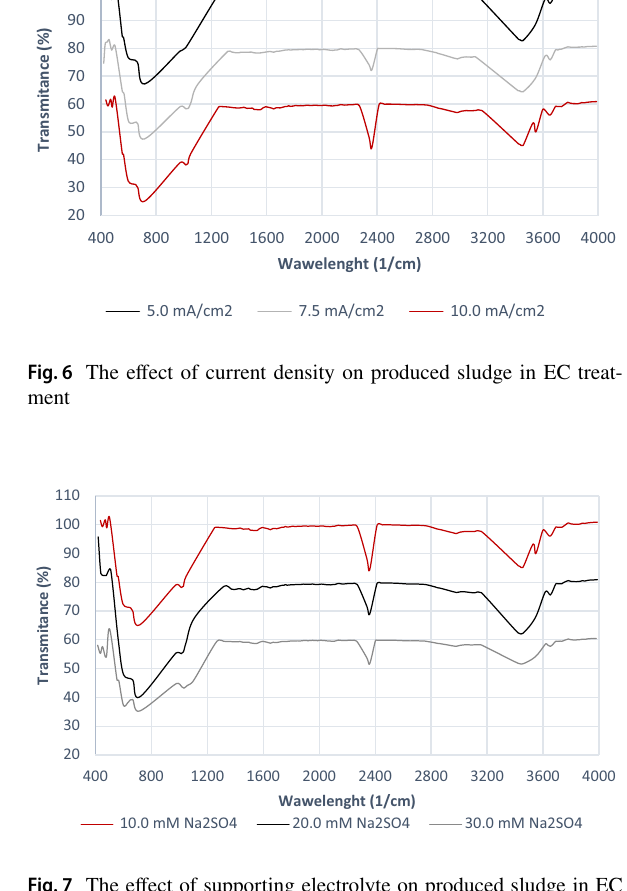
Fig. 7 The effect of supporting electrolyte on produced sludge in EC treatment